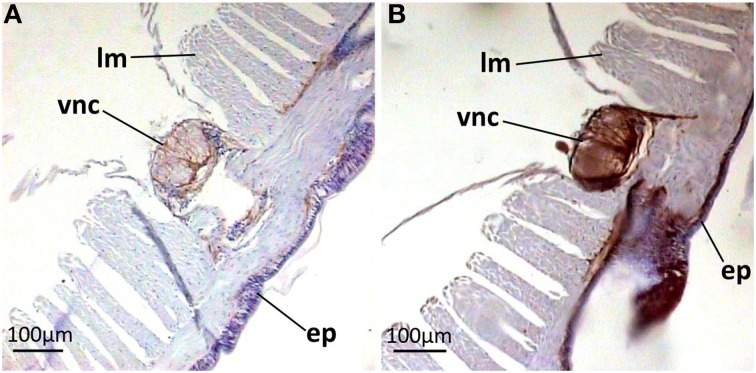
Arenicin-positive immunoreactivity of lugworm nervous system. A,B, sector of dorsal body part; A, negative control; ep, body wall epithelium; lm, longitudinal musculature; vcn, ventral nervous chain.